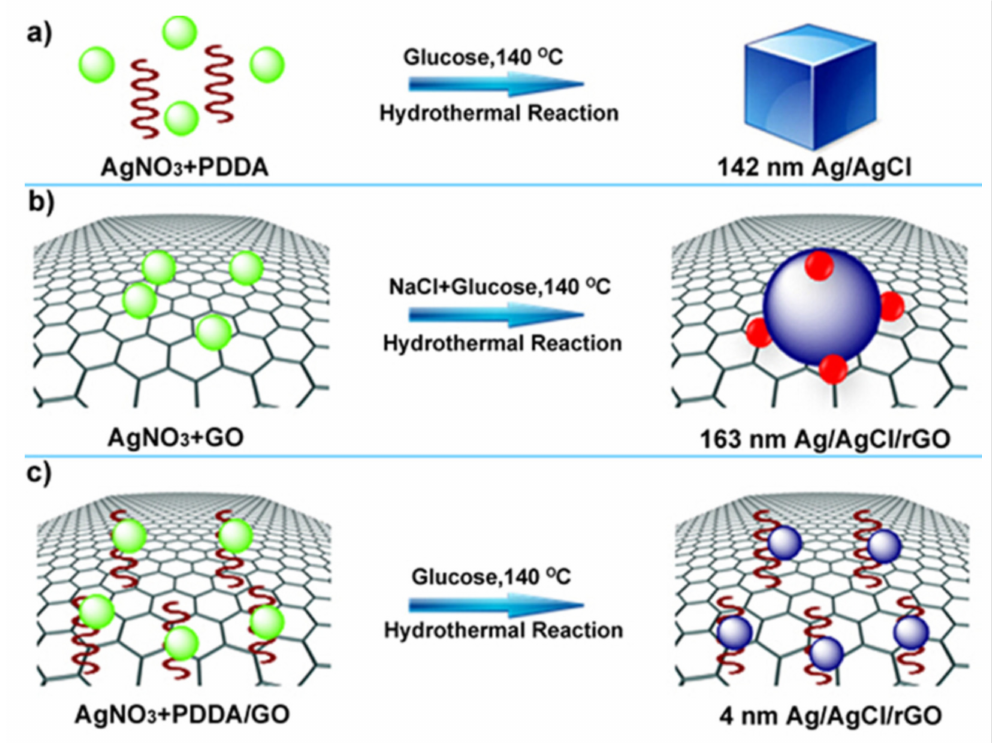
Figure 2. Schematic illustration of the size and shape of Ag/AgCl NPs controlled by ( a ) the PDDA surfactant, ( b ) GO sheets, and ( c ) both PDDA and GO (adapted with permission from reference [63]).